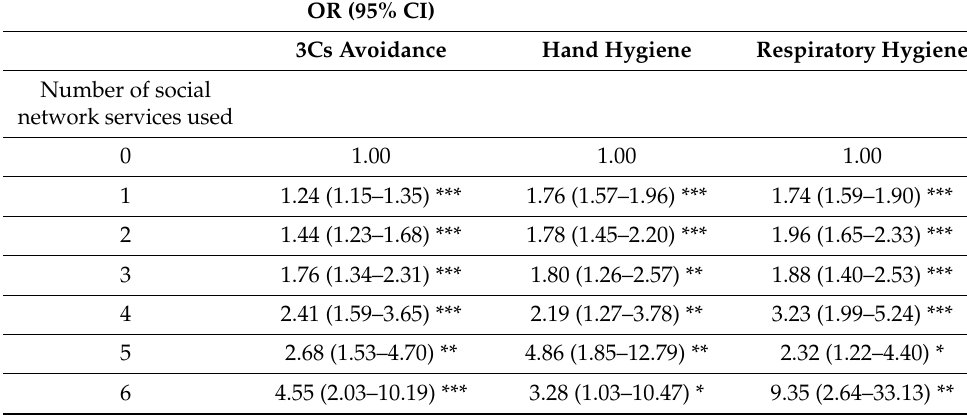
Table 4. Number of social network services used and adoption of preventive measures. OR (95% CI) 3Cs Avoidance Hand Hygiene Respiratory